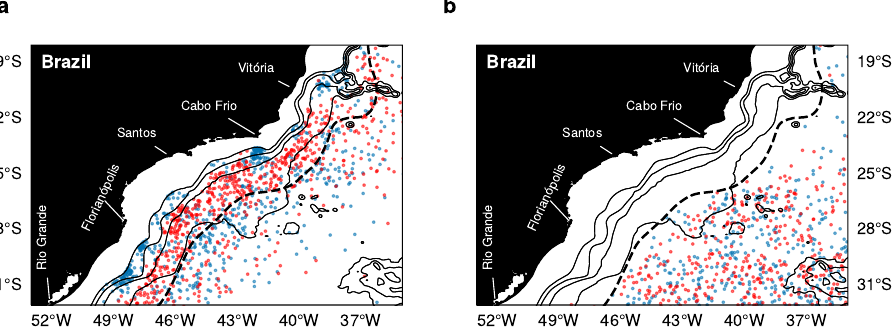
Figure 6. Location of first detection of unique long-lived compact eddies in the South Brazil Bight, with blue dots representing cyclones and red dots anticyclones. ( a ) Local Brazil Current eddies and remote eddies that at some time were observed in the Brazil Current region, west of the of black dashed line. ( b ) Remote eddies that were never observed west of the black dashed line. Several remote eddies have origins east of 35 ◦ W and thus are not represented in ( b ). Solid black lines depict the 200, 1000, 2000 and 3000-m